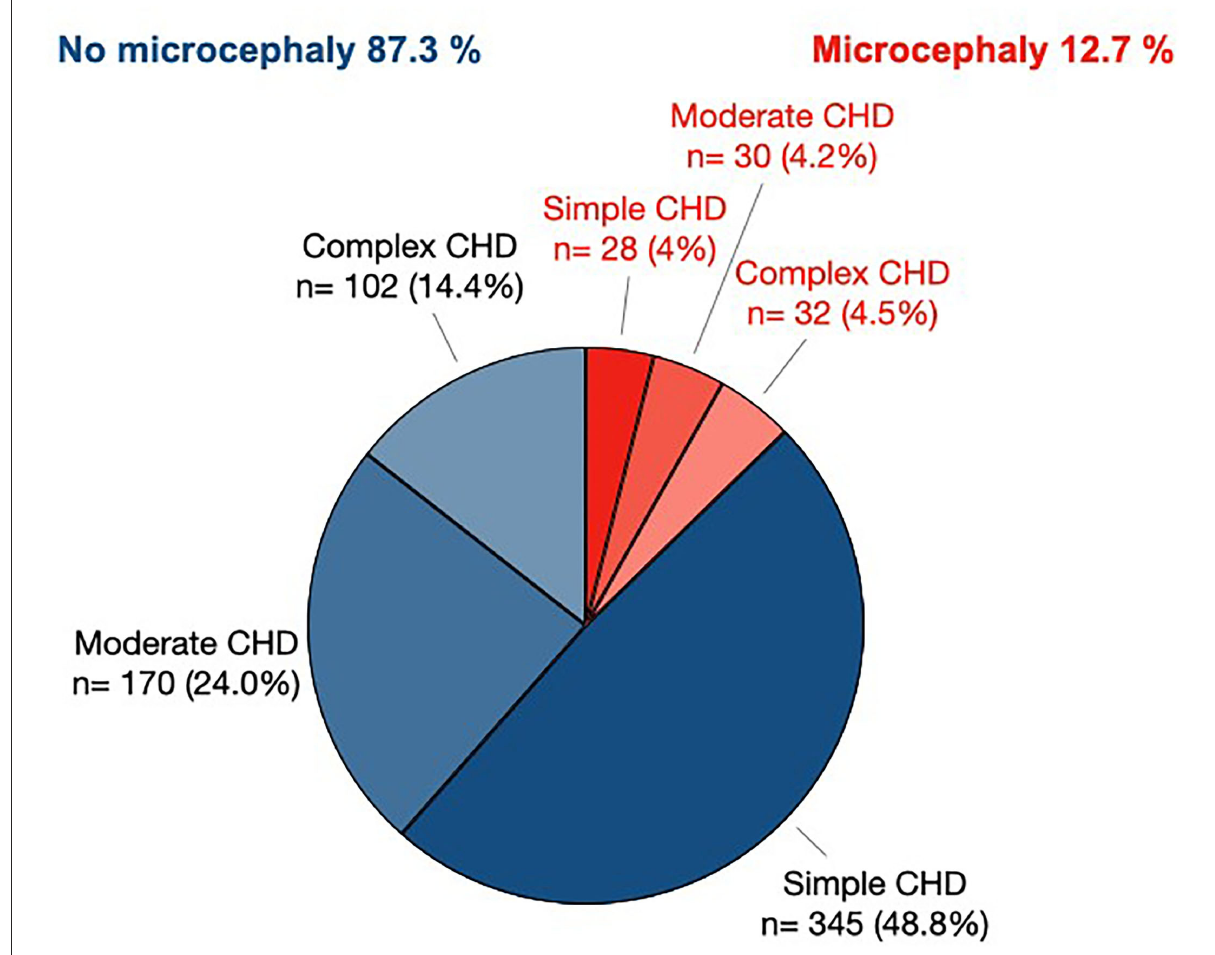
FIGURE2 Prevalence of microcephaly in patients with simple, moderate, or complex CHD. The pie chart denotes the raw n of patients defined by CHD severity classification and head circumference. Only patients with known CHD severity scores and known head circumference are included ( n =